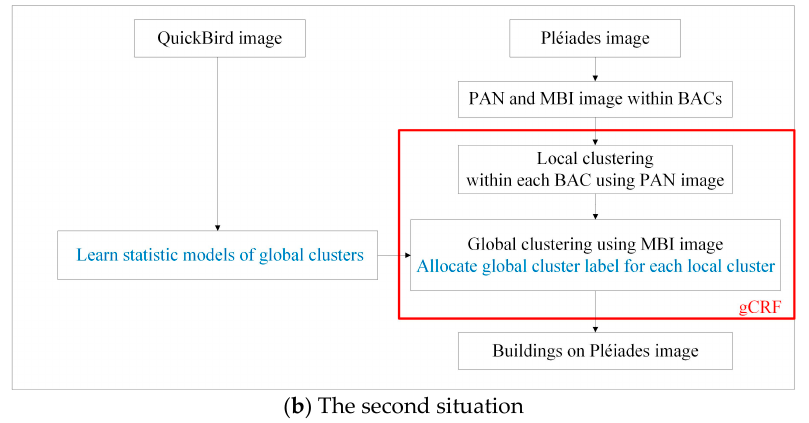
Figure 5. Algorithm for multiple heterogeneous VHR satellite images: ( a ) The first situation and ( b ) the second situation.